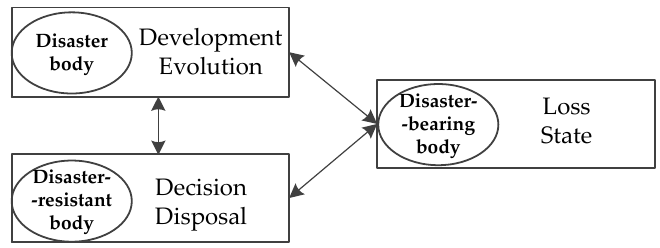
Figure 2. 3D structure of the elements of water environmental emergency scenario.